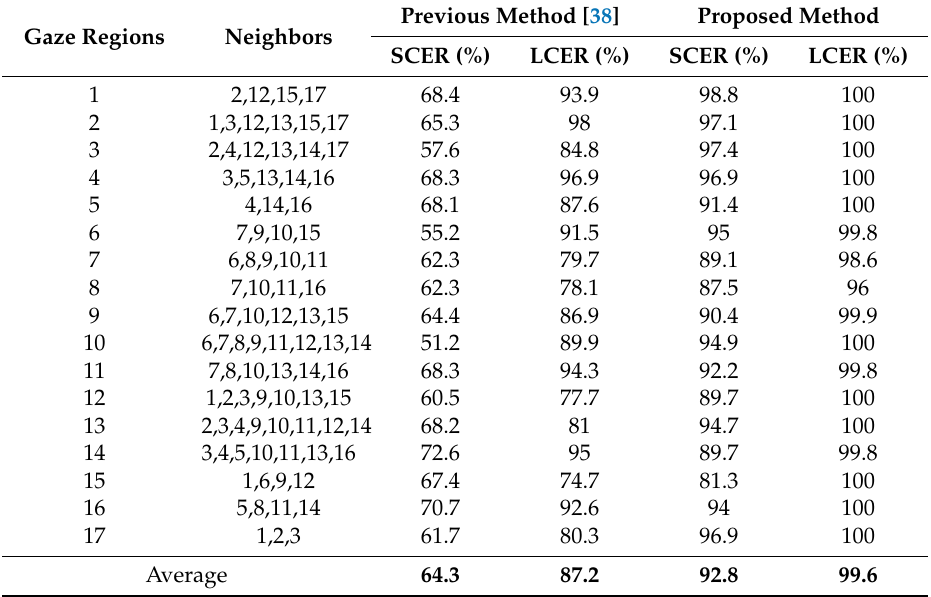
Table 10. SCER and LCER of previous method [38] and proposed method on DDGC-DB1. Gaze Regions